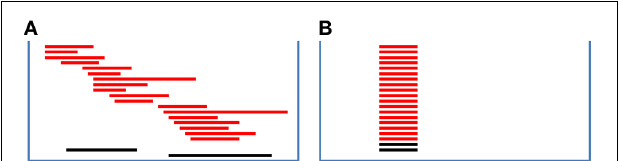
FIGURE 1 | Recurrent CNVs and randomly distributed CNVs in a given genomic region. Each red (black) bar represents a CNV in a case (control). (A) shows CNVs with locations randomly distributed in the region and (B) shows recurrent CNVs with identical boundaries. In both figures, there are 18 cases carrying CNVs while two controls carrying CNVs. Assuming equal number of cases and controls, CNVs more frequently disrupt the genomic region in cases than in controls. When CNV status is known, the association can be tested using the Fisher’s exact test.